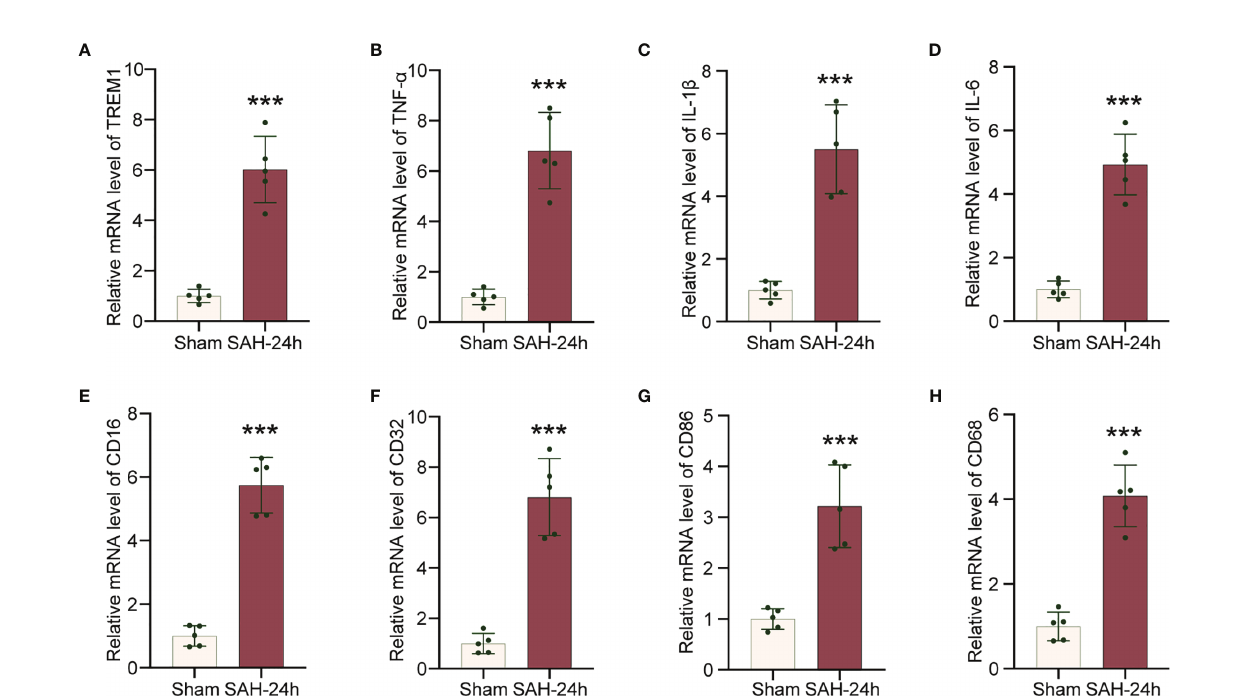
FIGURE 2 | Increased levels of in fl ammatory genes in cerebral cortex after SAH. (A – H) . Real-time PCR analysis of TREM1, TNF- a , IL-1 b , IL-6, CD16, CD32, CD86, and CD68. Data are expressed as mean ± SD, n = 5 in each group. ***p < 0.001 vs. sham